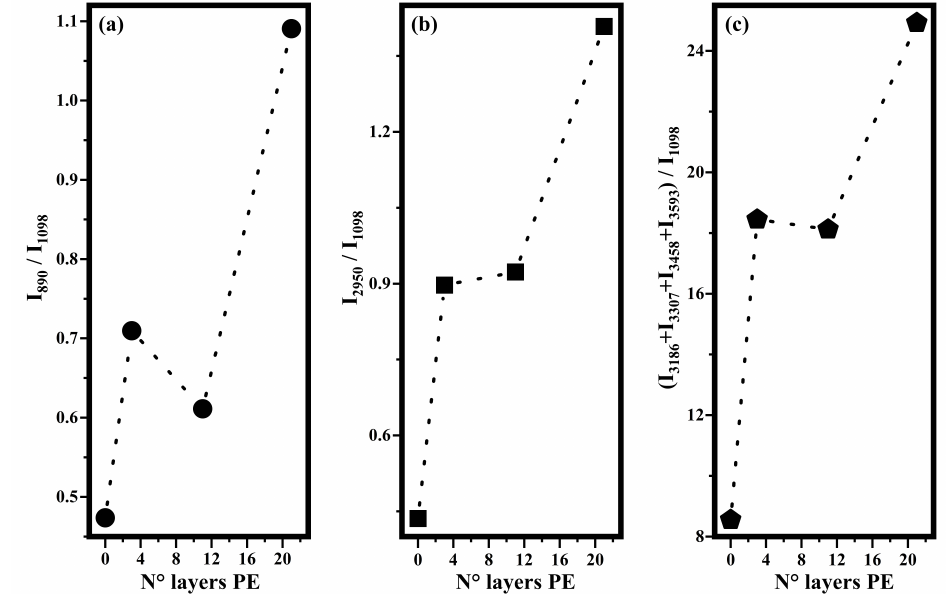
Figure 6. Trends, as a function of the number of the PE layers, of the ratios of intensities bands that fall at frequencies indicated as subscripts in I 890 /I 1098 ( a ), I 2950 /I 1098 ( b ), and (I 3186 + I 3307 + I 3458